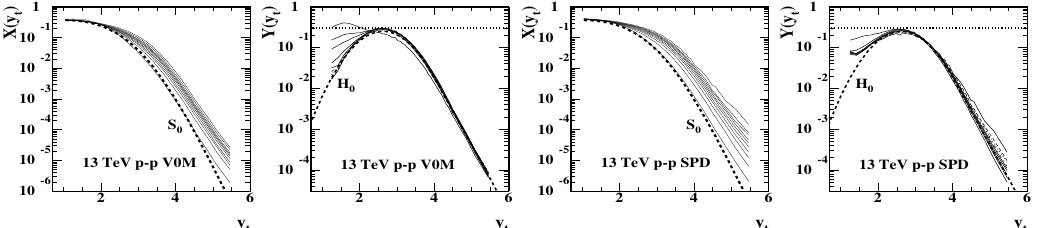
) and inferred jet-related hard components t